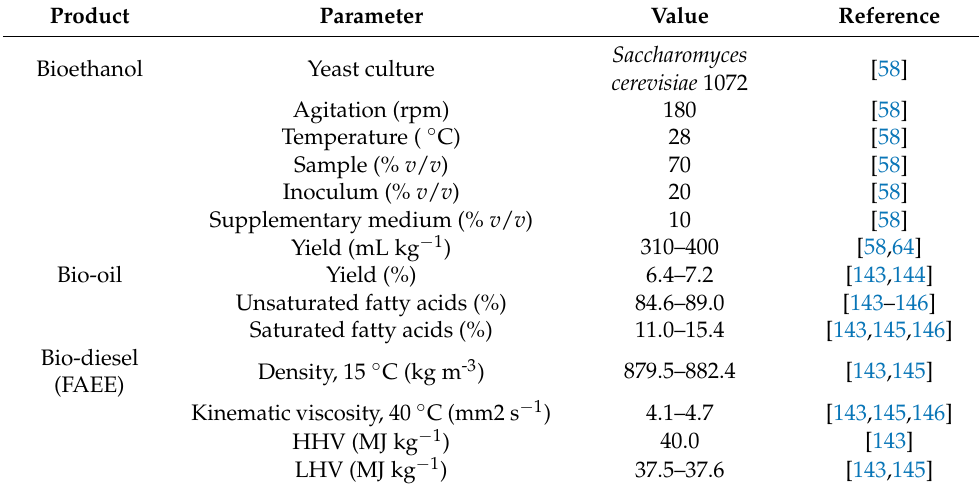
Table 15. Characteristics of bioethanol, bio-oil and biodiesel produced from winery